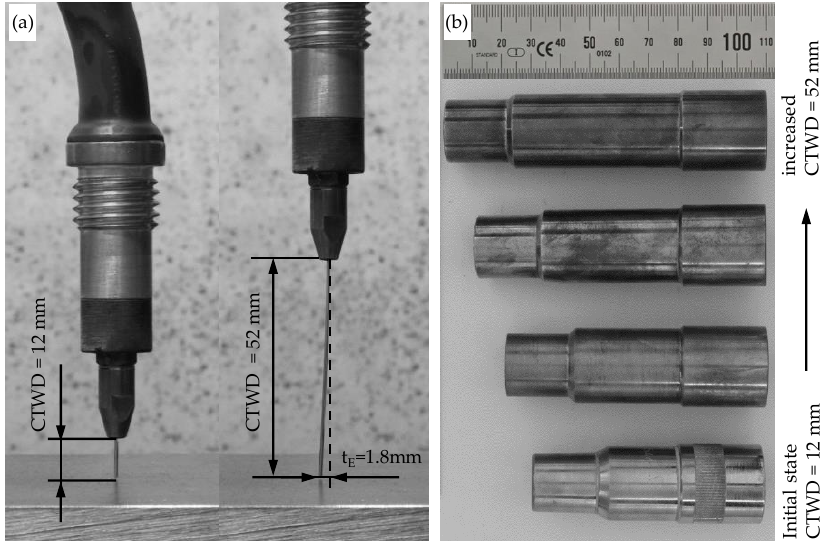
Figure 3. ( a ) Measurement of electrode spin with increased CTWD and ( b ) adaptation of shielding gas nozzles for gas metal arc welding (GMAW) with increased CTWD.